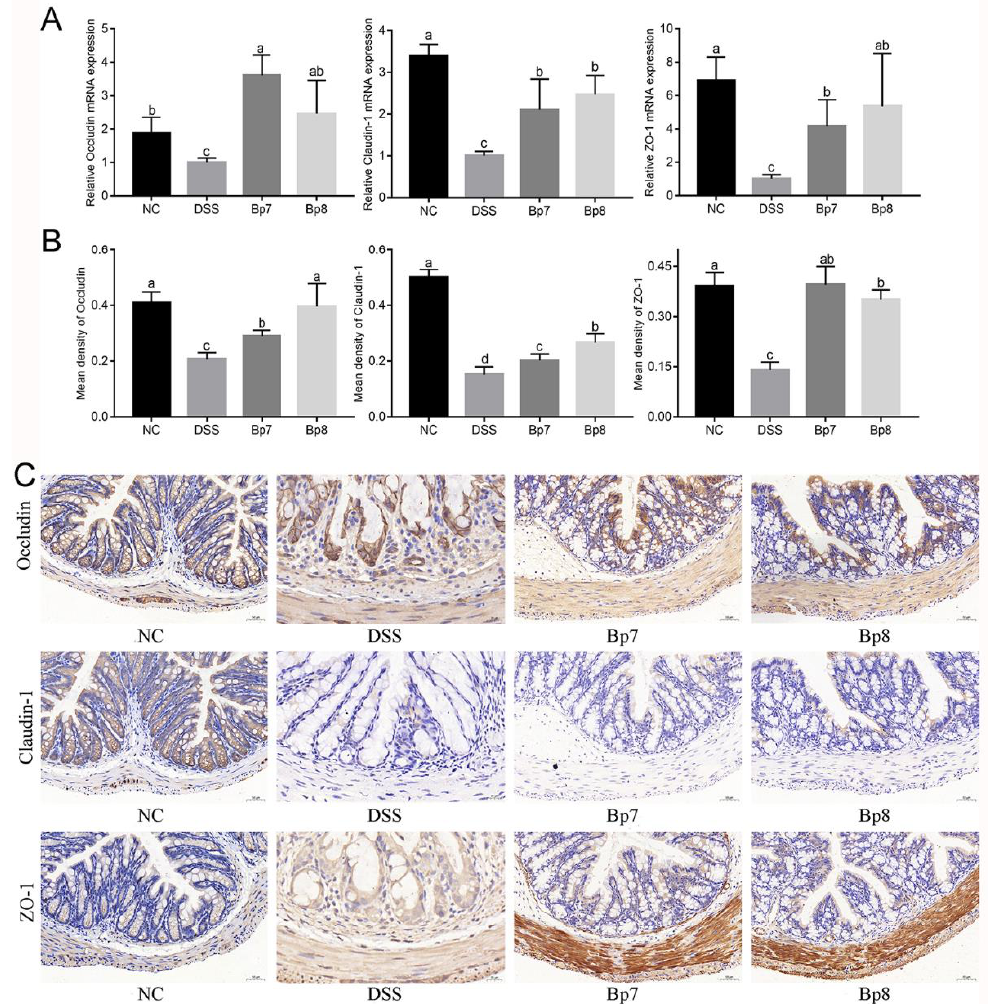
Figure 5. Influence of Bp7 and Bp8 intervention on the tight junction protein in the colon. The mRNA expression of colonic occludin, claudin-1, and ZO-1 ( n = 8) ( A ); the mean density of colonic occludin, claudin-1, and ZO-1 ( n = 8) ( B ); immunohistochemical staining for occludin, claudin-1, and ZO-1 ( C ). The different letters represent significant differences between experimental groups ( p < 0.05).